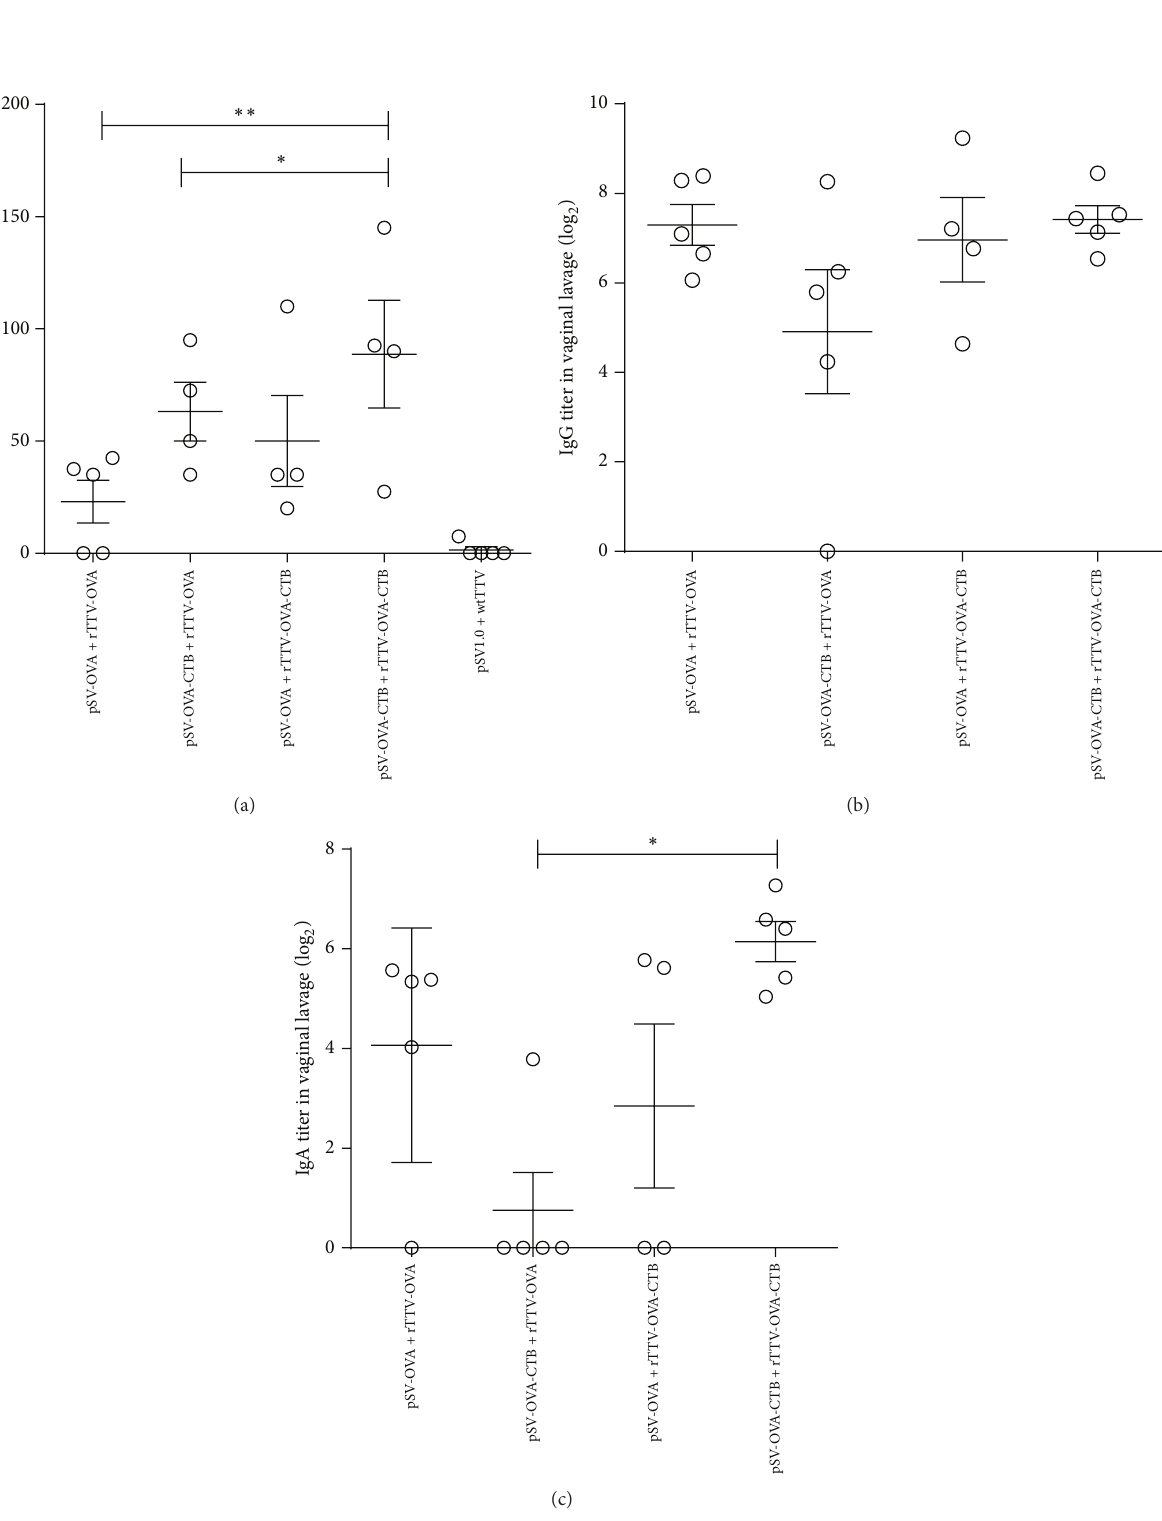
Figure 3: Specific antibody and T-cell immune responses elicited in female genital tract. (a) T lymphocytes responses in inguinal and iliac lymph nodes. The T-cell responses of rTTV-OVA-CTB boosting groups were significantly higher than those of rTTV-OVA boosting groups. (b) Specific IgG responses in vaginal lavage. No significant difference was found among different groups. (c) Specific IgA responses in vaginal lavage. IgA titer elicited by pSV-OVA-CTB priming/rTTV-OVA-CTB boosting group was significantly higher than pSV-OVA priming/rTTV- OVA-CTB boosting group. ∗ 𝑃 < 0.05 , ∗∗ 𝑃 < 0.01